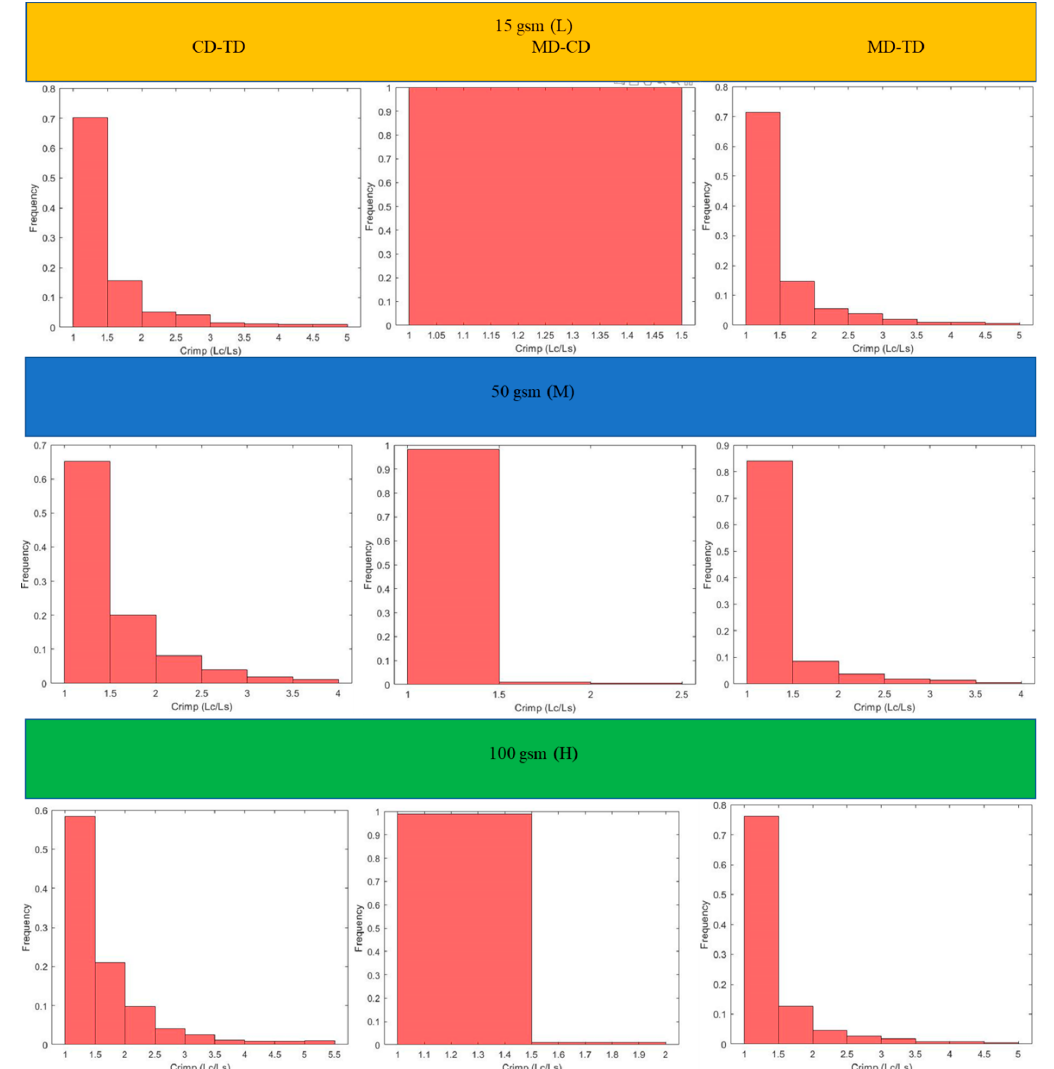
Figure 12. Two-dimensional crimp of non-crimped fabrics.